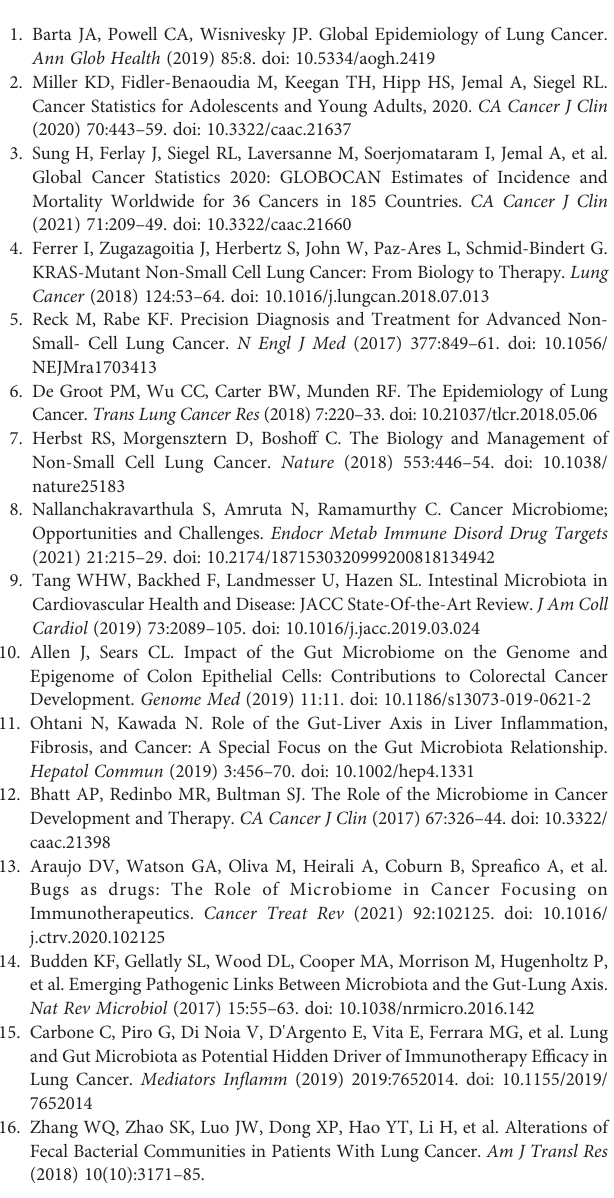
individuals; LUAD, Lung adenocarcinoma. ***P < 0.001. Supplementary Figure 2 | Taxonomy comparison of the gut microbiome with Metagenomics. (A) The distribution of the top 10 phyla in two groups. (B) The distribution of the top 10 genera in two groups. (C) The differential distribution of